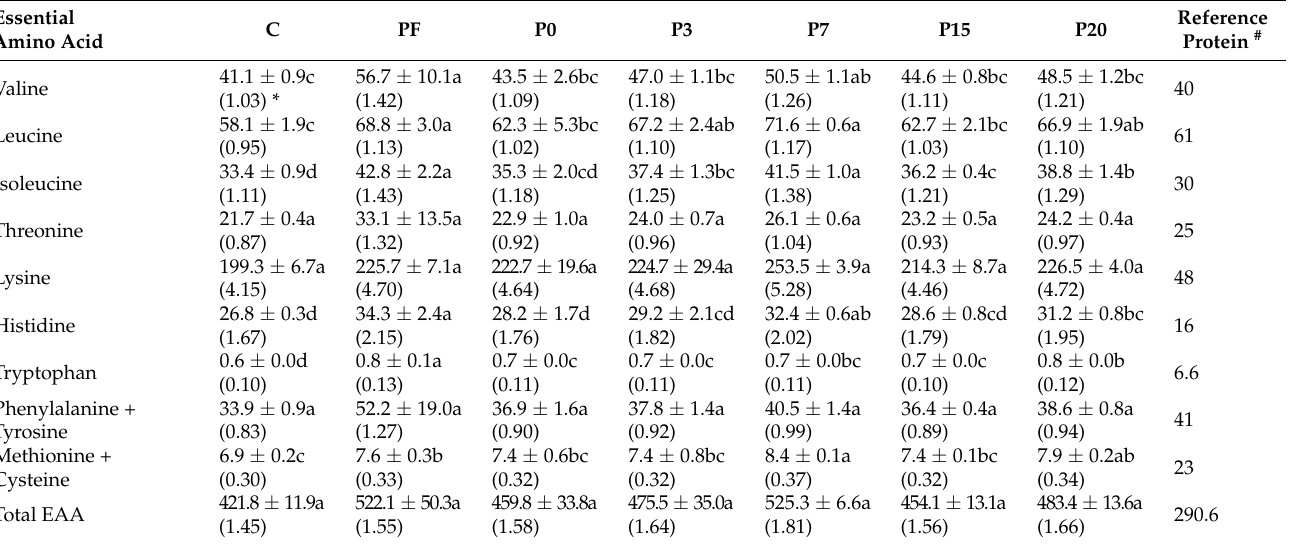
Table 8. Recommended amino acid scores for adult (mg/g protein) of sago palm weevil larvae (SPWL) fed with different diets compared to referent